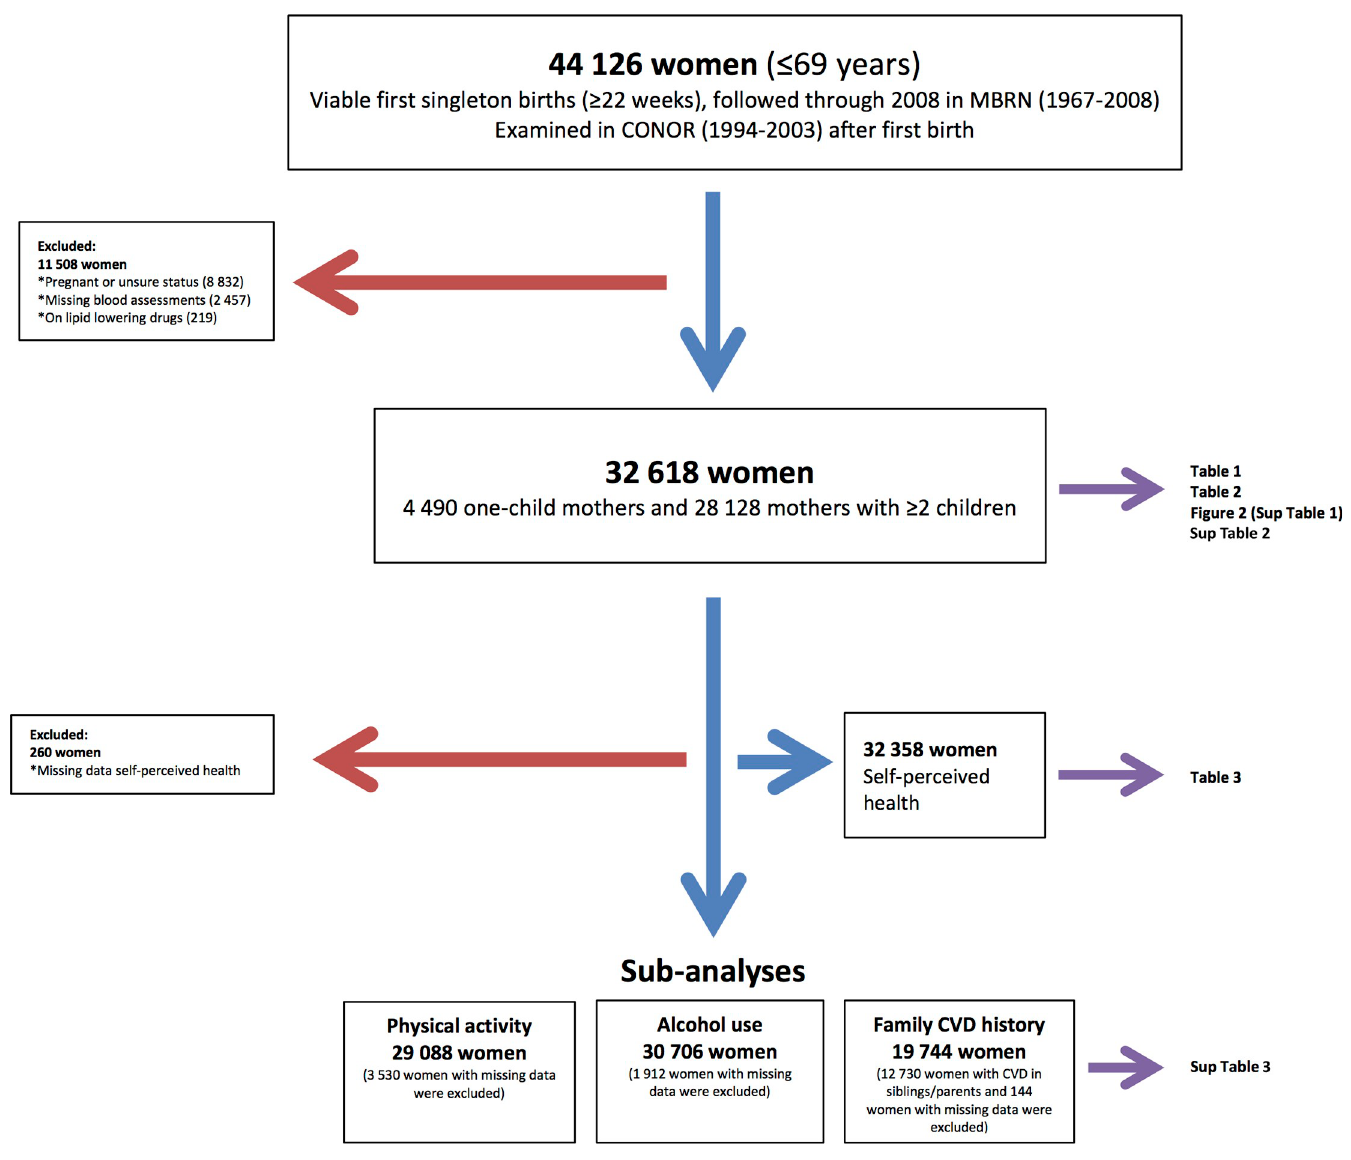
Fig 1. Flow chart of inclusions and